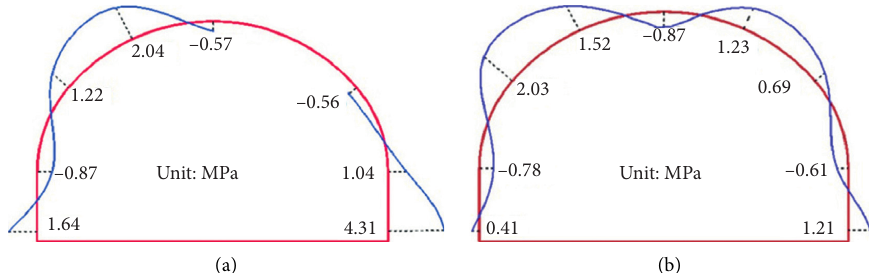
Figure 16: Stress distribution of secondary lining concrete at section YK2+449. (a) Stress maximum of outer side of concrete. (b) Stress maximum of inner side of concrete.